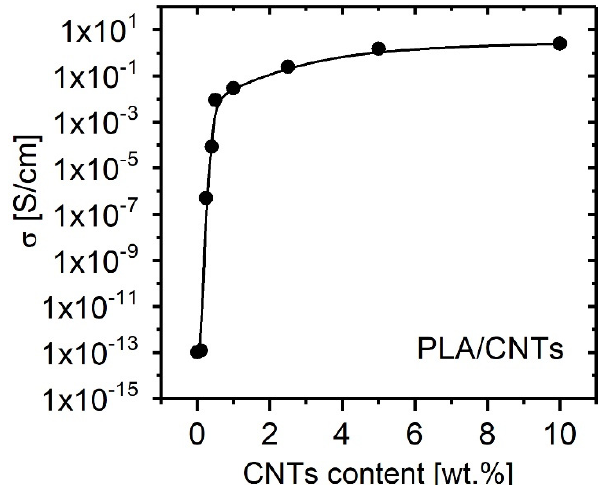
Figure 7. Percolation curve plot—PLA/CNT nanocomposites specific conductivity vs CNT weight content.